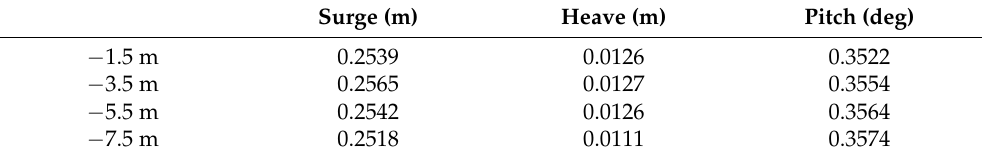
Table 14. Motion RMS with different auxiliary rope fairlead positions under normal operating con- ditions.